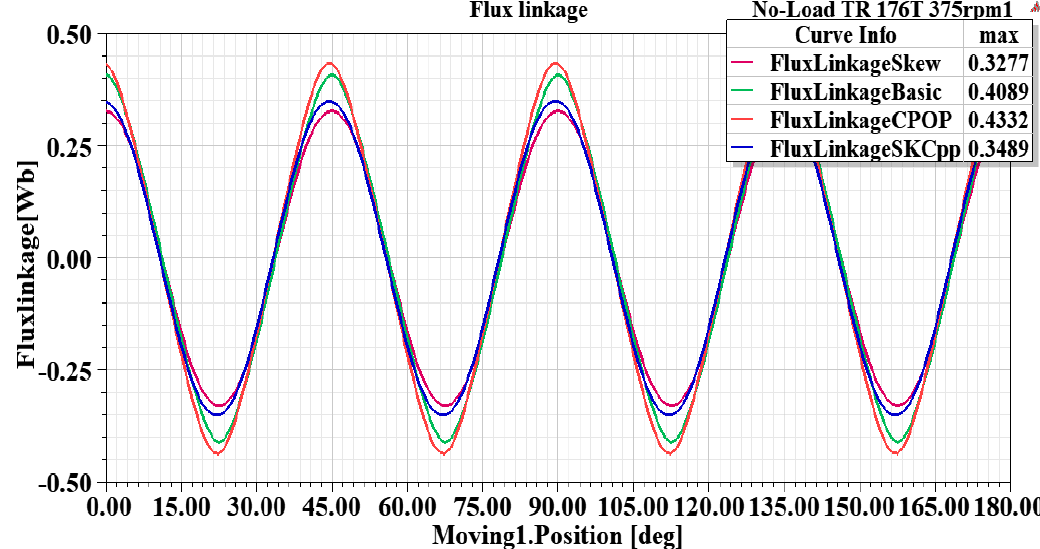
Figure 25. Flux linkage waveforms comparison.